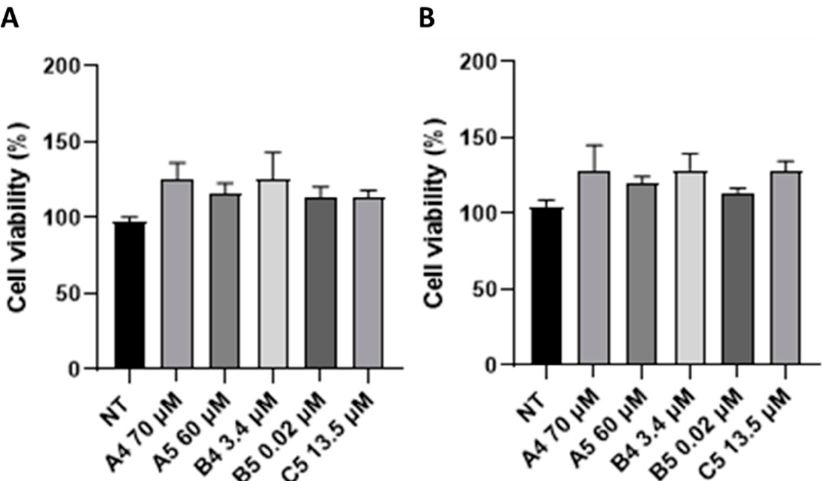
Figure 3. MTS analysis of SUP-T1 cell viability/metabolism at ( A ) 1 and ( B ) 4 h p.t. GEs were used according to the concentration reported in the BIOPEP database. Analysis was performed on three independent biological replicas. SEM bars are reported.